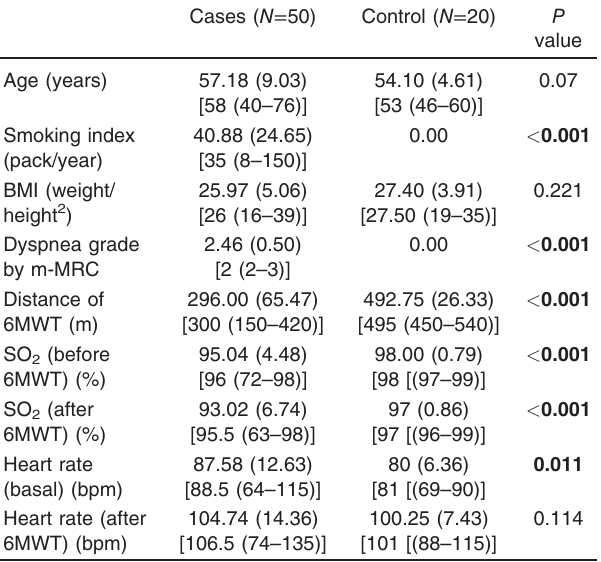
Table 1 The demographic and clinical parameters of the patients with chronic obstructive pulmonary disease and the